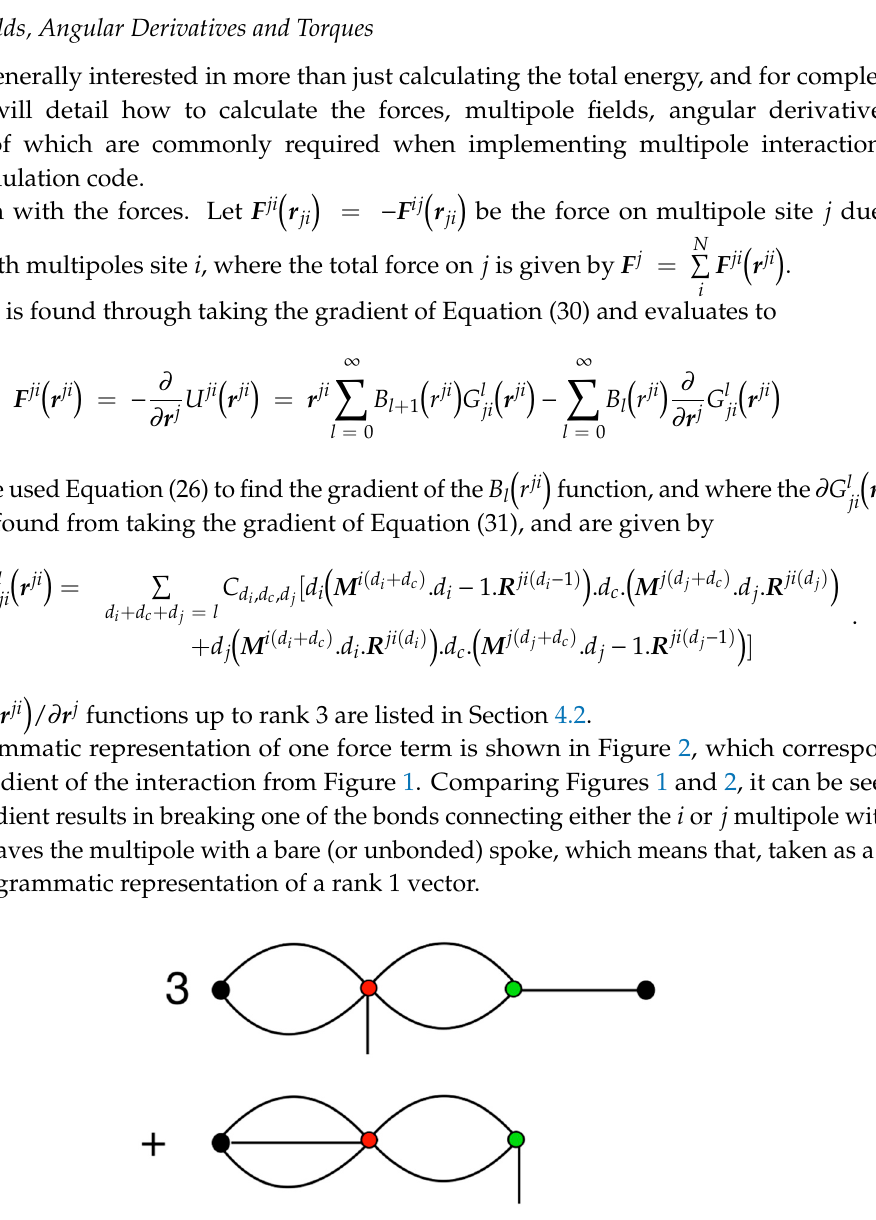
Figure 2. A force term obtained from taking the gradient of the term in Figure 1, which equates to 3 ( M i ( 5 ) : R ji ( 2 ) ) : ( M j ( 3 ) . R ji ( 1 ) ) + ( M i ( 5 ) . R ji ( 3 ) ) : M j ( 3 ) .